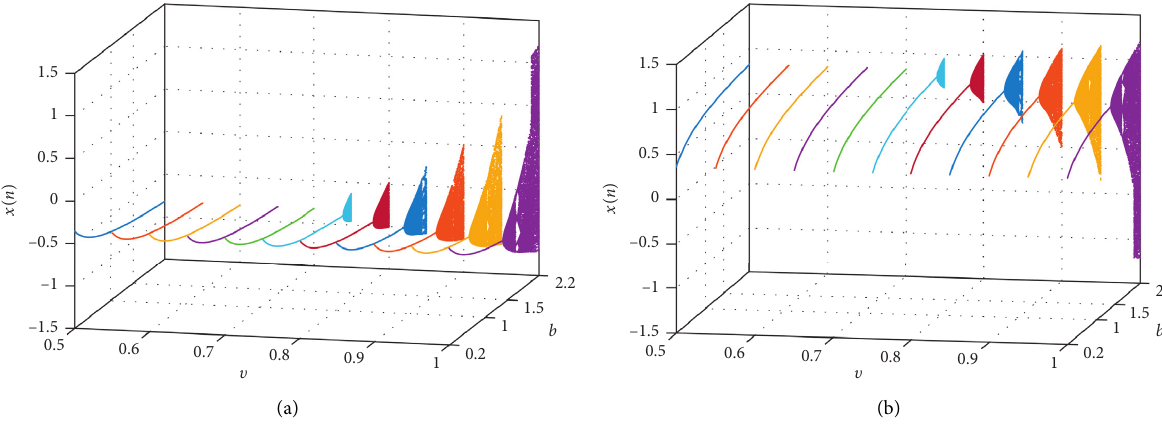
Figure 11: Bifurcation diagrams for map (10) with different initial values as the parameter b and the order υ vary: (a) the bifurcation diagram and (b) the bifurcation diagram with x with x 01